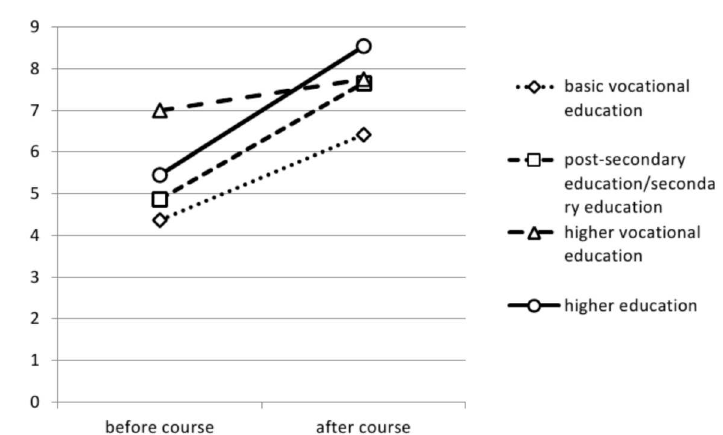
Figure 1. Mean values of knowledge of nutritional standards depending on education and testing